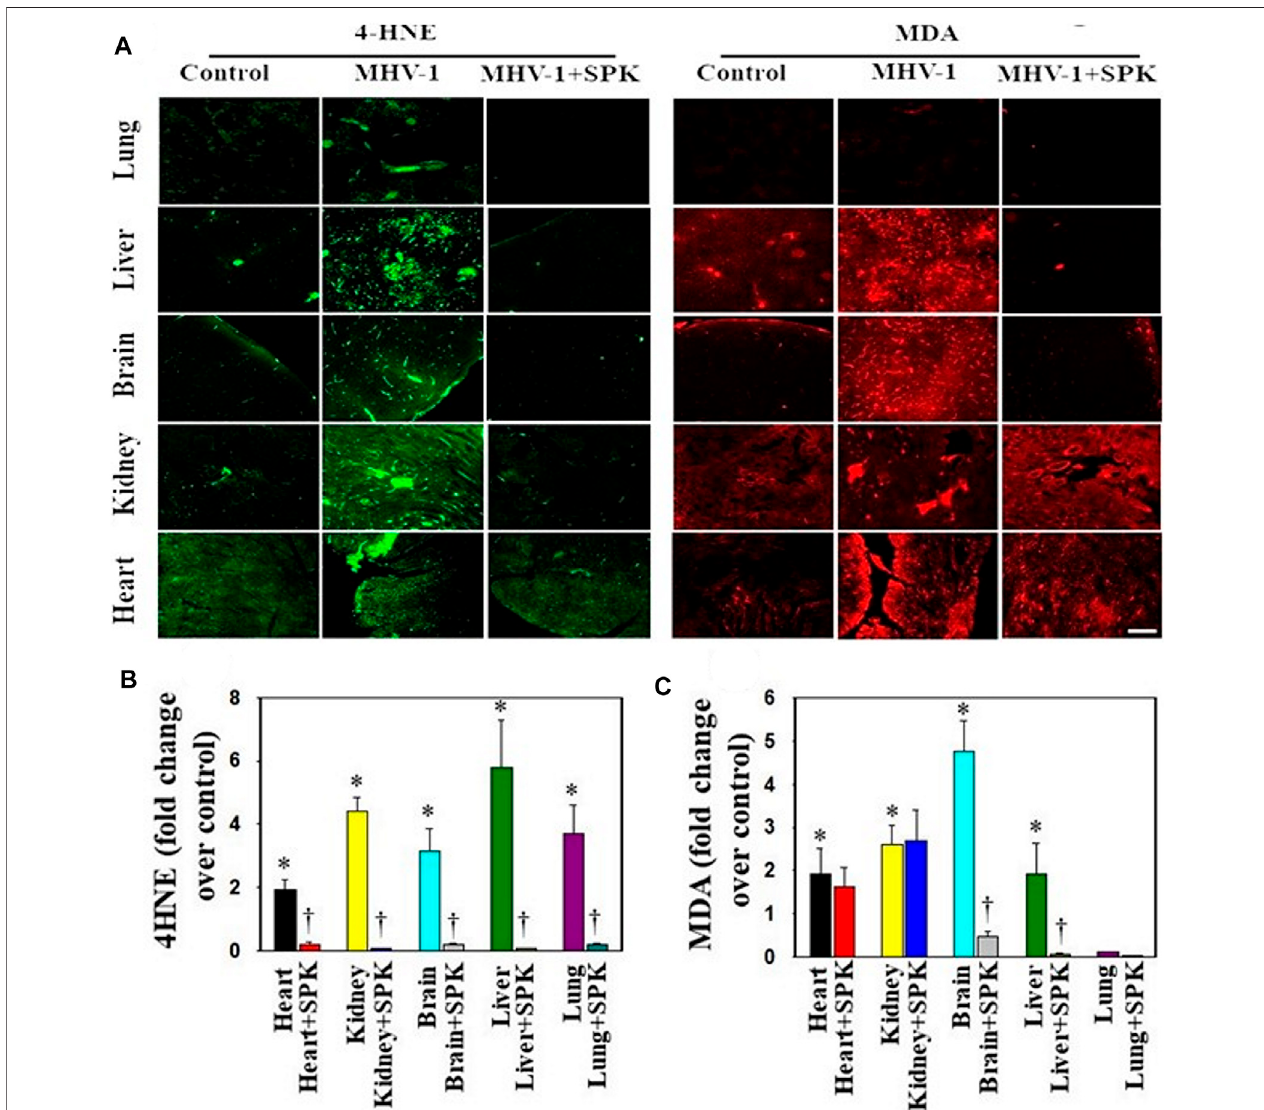
FIGURE11| Oxidativestresspost-MHV-1infectioninmice. (A) Representativeimmuno fl uorescenceimagesfromfourindividualanimalsshowanincreaseinlevels of 4-hydroxynonenol (4-HNE) and malondialdehyde (MDA) in lung, liver, kidney, brain and heart. Treatment of MHV-1 inoculated mice with SPK (5 mg/kg) prevented such an increase. (B,C) Quantitation of 4-HNE and MDA levels with and without SPK post-MHV-1 infection. ANOVA, n = 4. * p < 0.05 versus control; † p < 0.05 verses MHV-1 infected mice. Scale bar = 25 μ m. Error bars represent mean ± SEM.